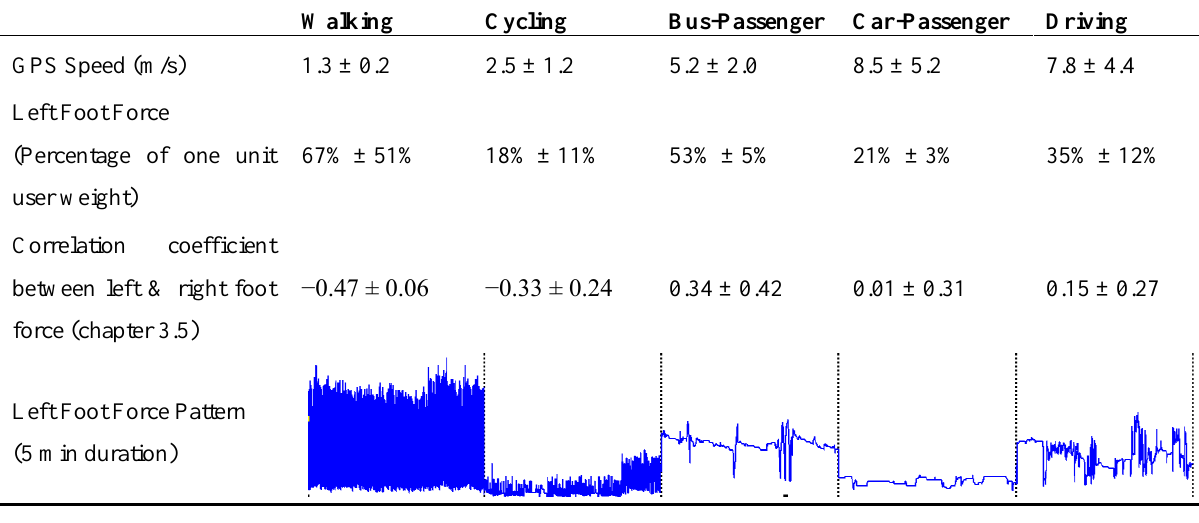
Table 2. Variations in average speed and foot force patterns in different transportation